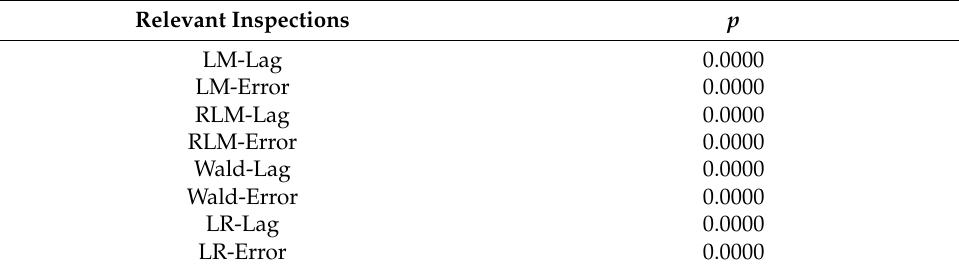
Table 10. Selection of spatial panel models.